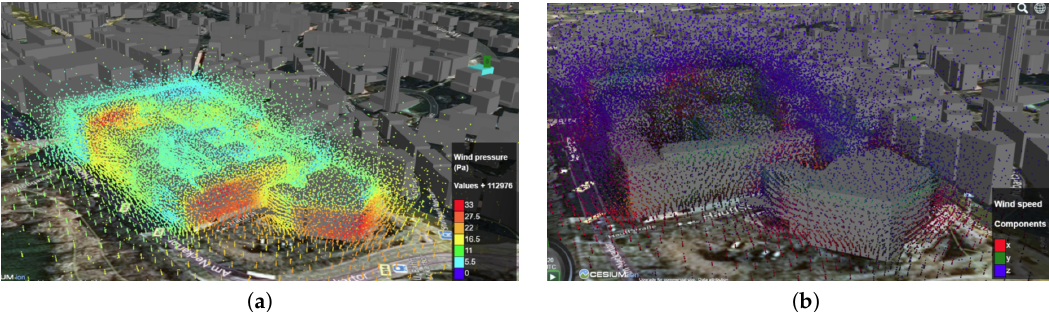
Figure 8. Visualization of CFD simulation results for Stuttgart-Neckartor as two examples of visualization schemes using point clouds. using point clouds. Please note that the left image ( a ) shows visualization of wind pressure in units of Pa while the right images ( b ) shows wind direction components ( x , y , z ) encoded into RGB.